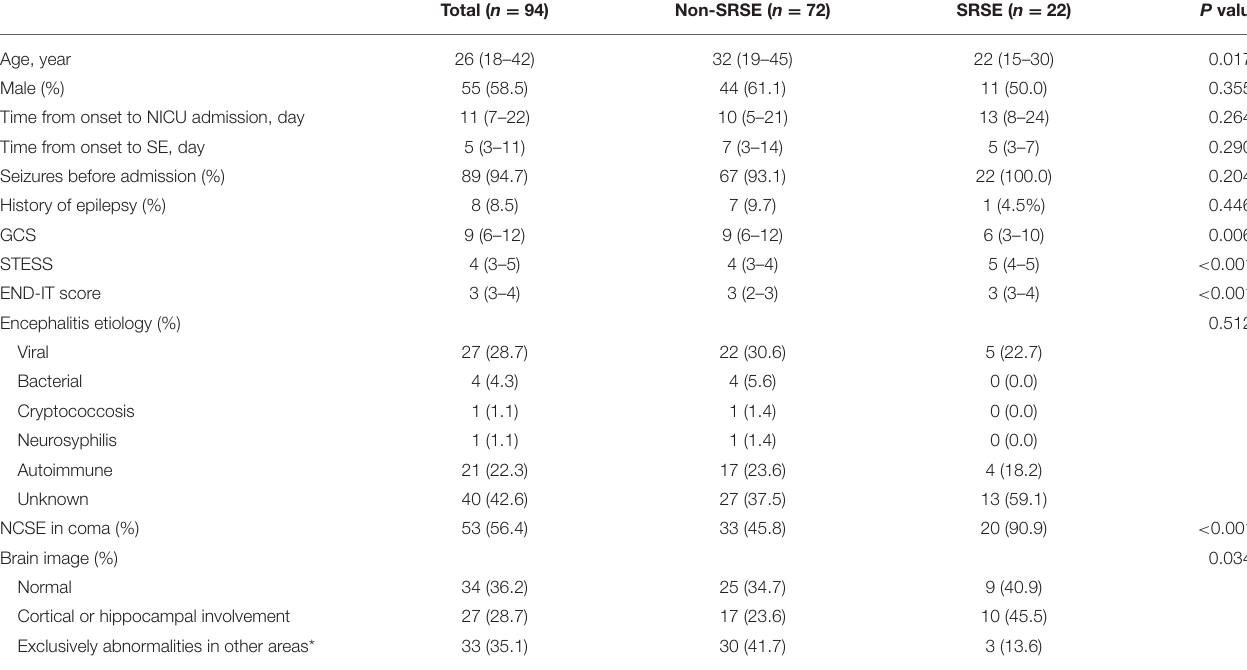
TABLE 1 | Demographics and clinical characteristics of patients with status epilepticus associated with acute encephalitis.